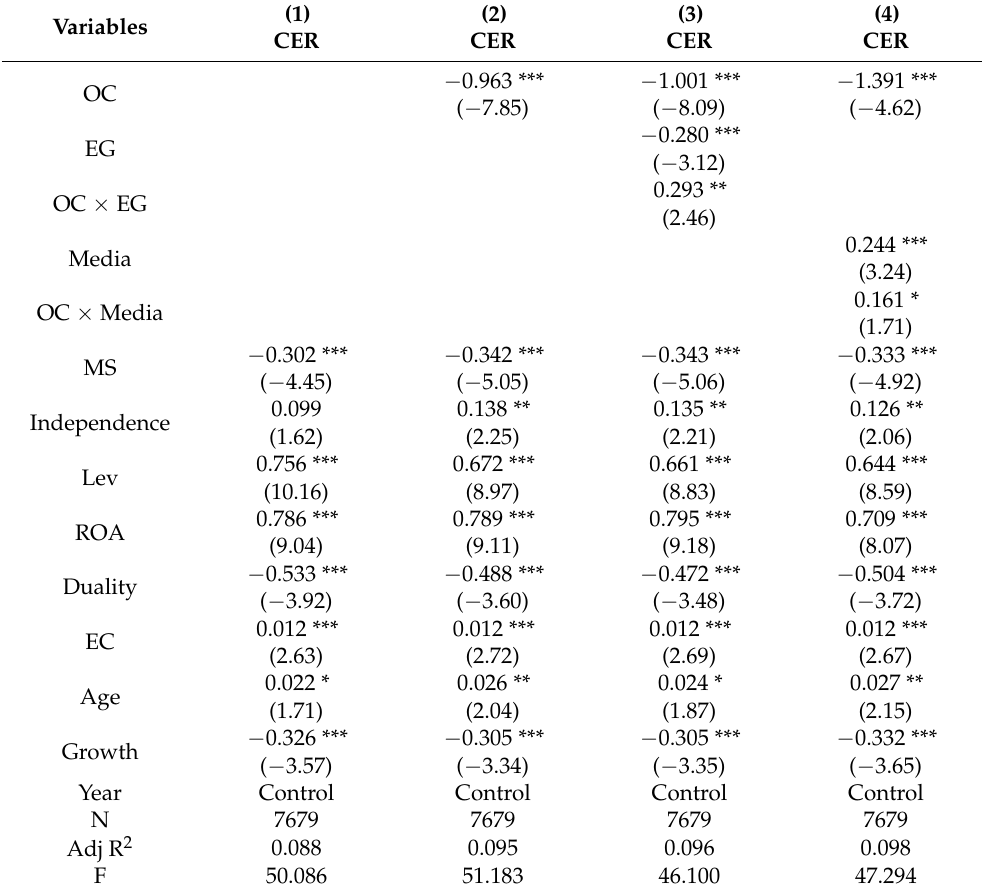
Table A4. PSM regression